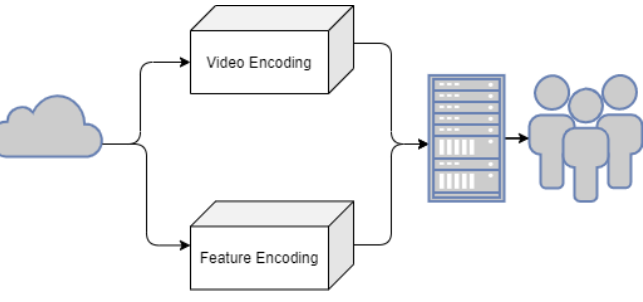
Figure 3. Cloud Services.